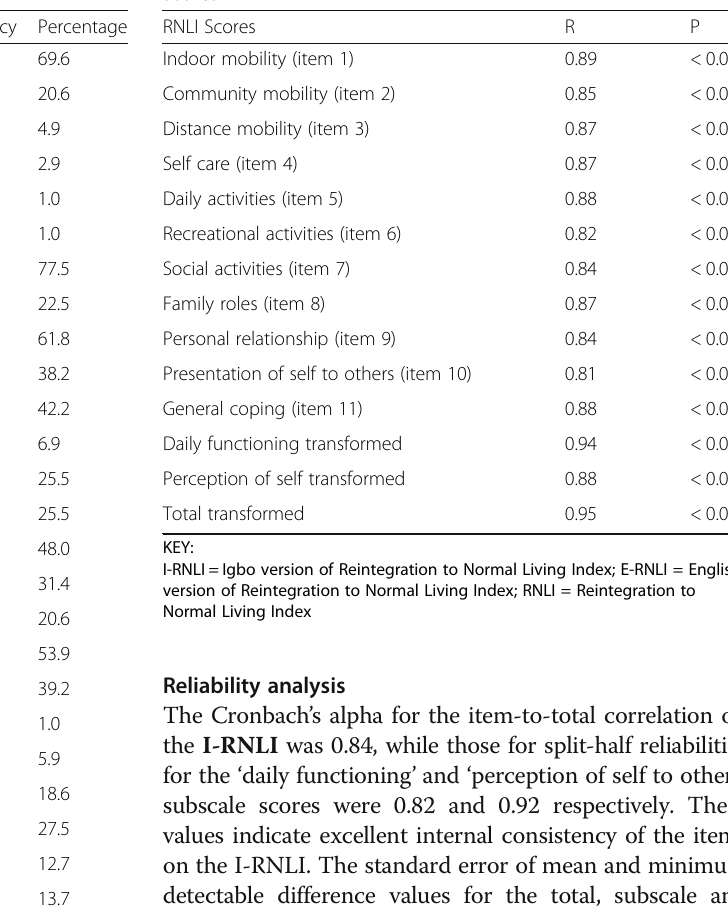
Table 2 Socio-demographic variables of individuals with Table 3 Spearman rank correlation between I-RNLI and